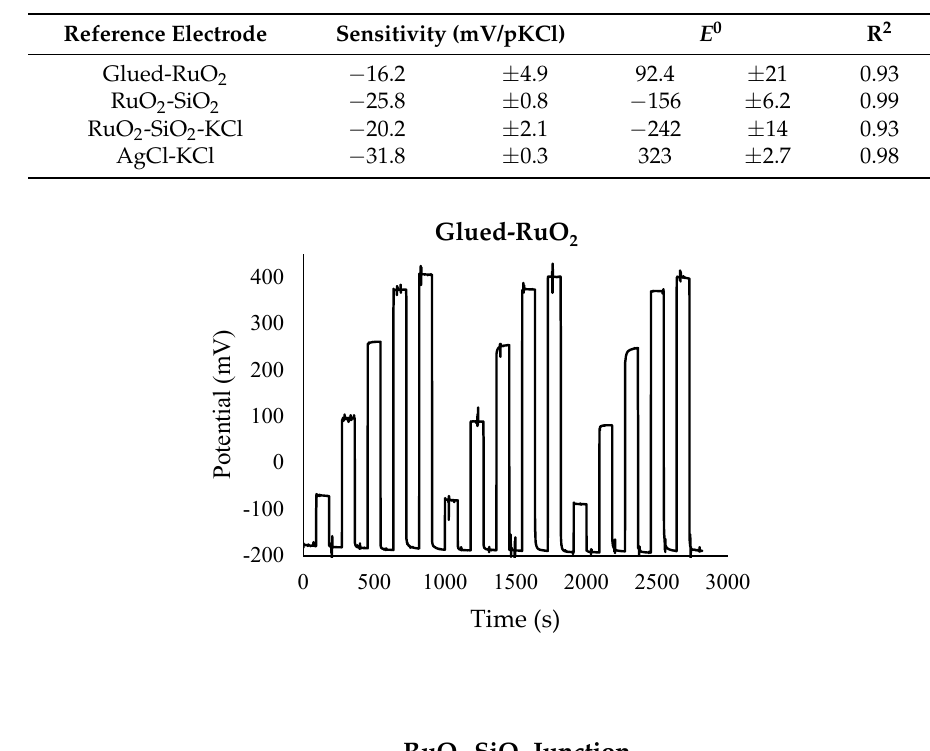
Table 4. Summary of KCl sensitivity values for RuO 2 pH sensors with RuO 2 -SiO 2 , RuO 2 -SiO 2 -KCl, Glued-RuO 2 , and AgCl-KCl reference electrodes.